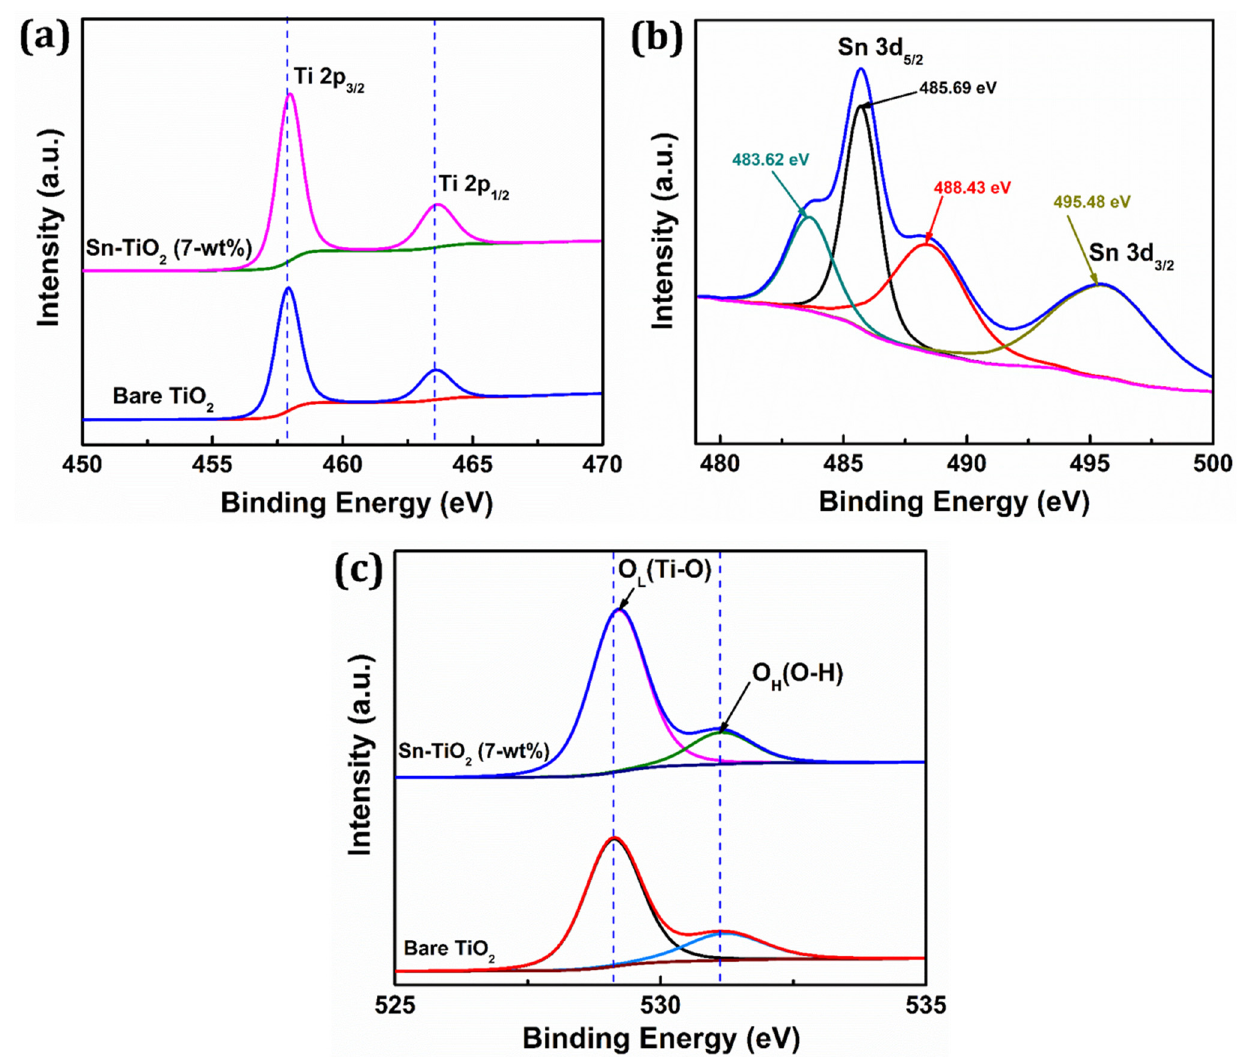
Figure 4. High-resolution XPS spectra of ( a ) Ti 2p, ( b ) Sn 3d, ( c ) O 1s fitting of bare TiO 2 and 7-wt % Sn-TiO 2 thin films .